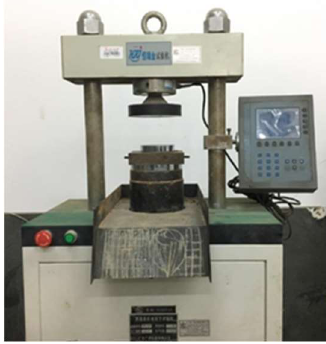
Figure 3. Liquid crystal automatic pressure testing machine.